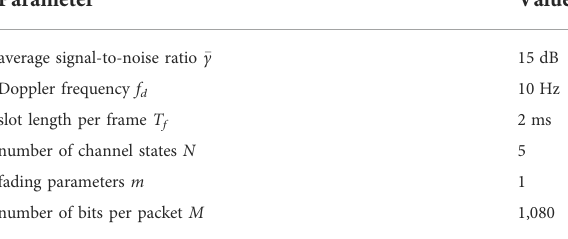
TABLE 2 Simulation parameters of the nonideal channel model.